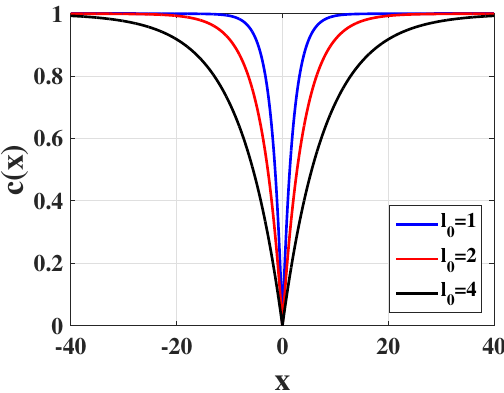
Figure 8. Second-order quadratic approximation: Effect on length-scale parameter l 0 on the width of